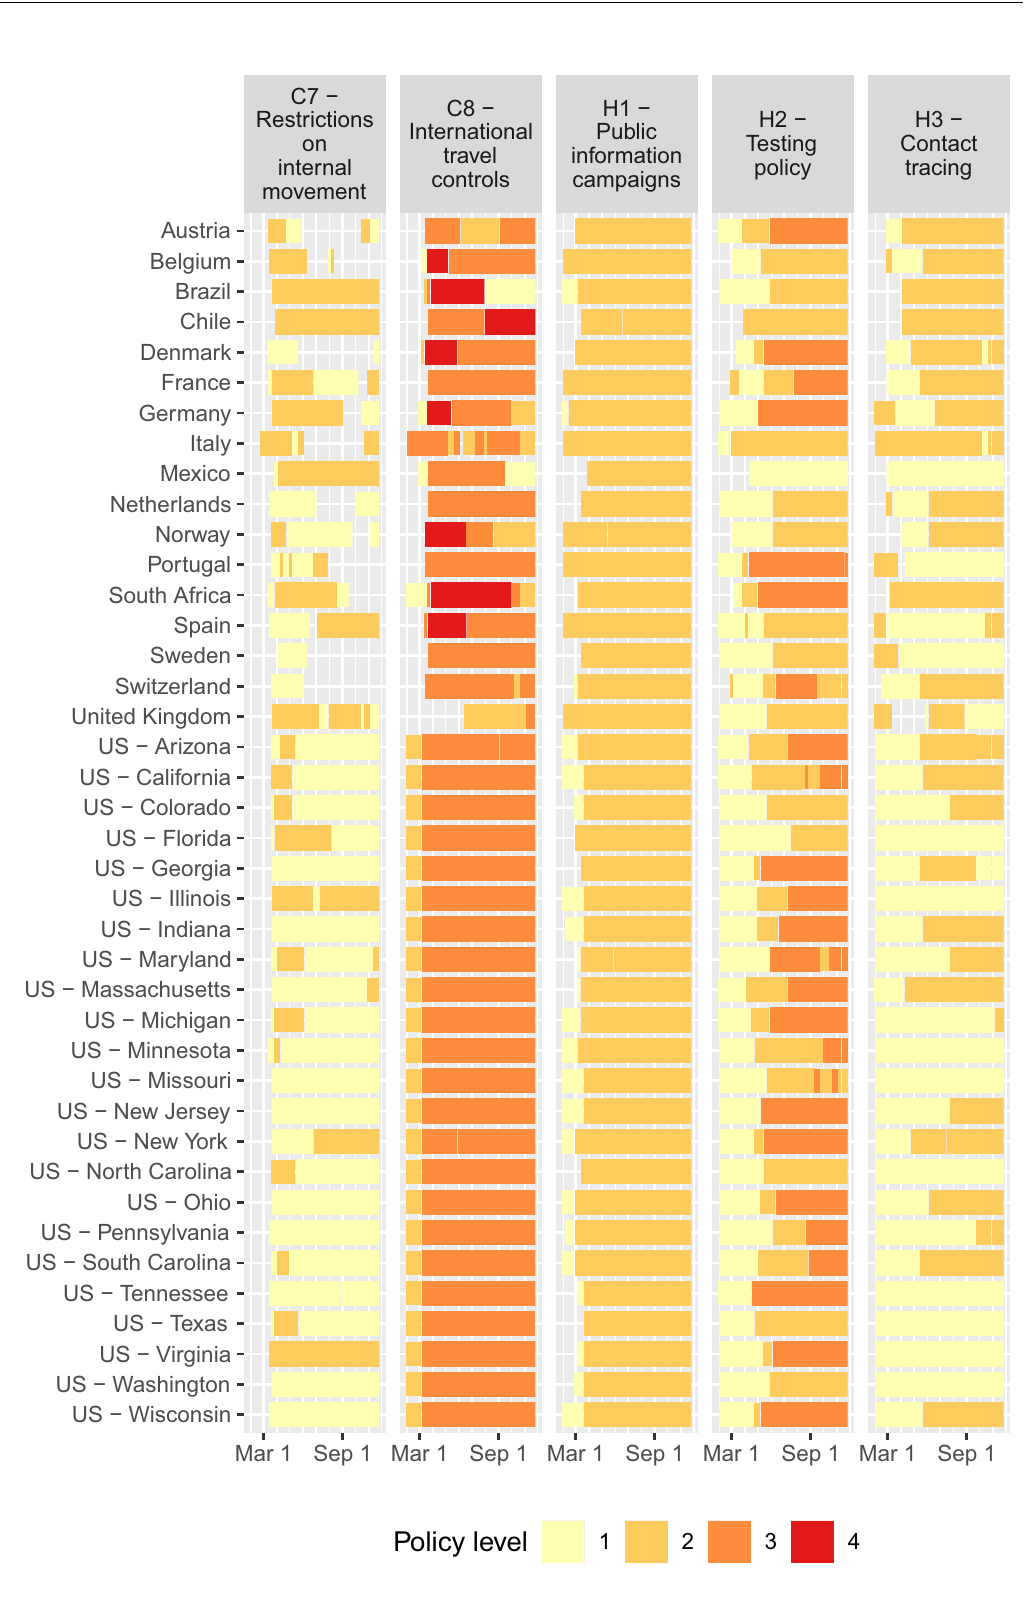
Fig 2. COVID policy levels by week based on OxCGRT database. Policies C7, C8, H1-H3; continued from Fig